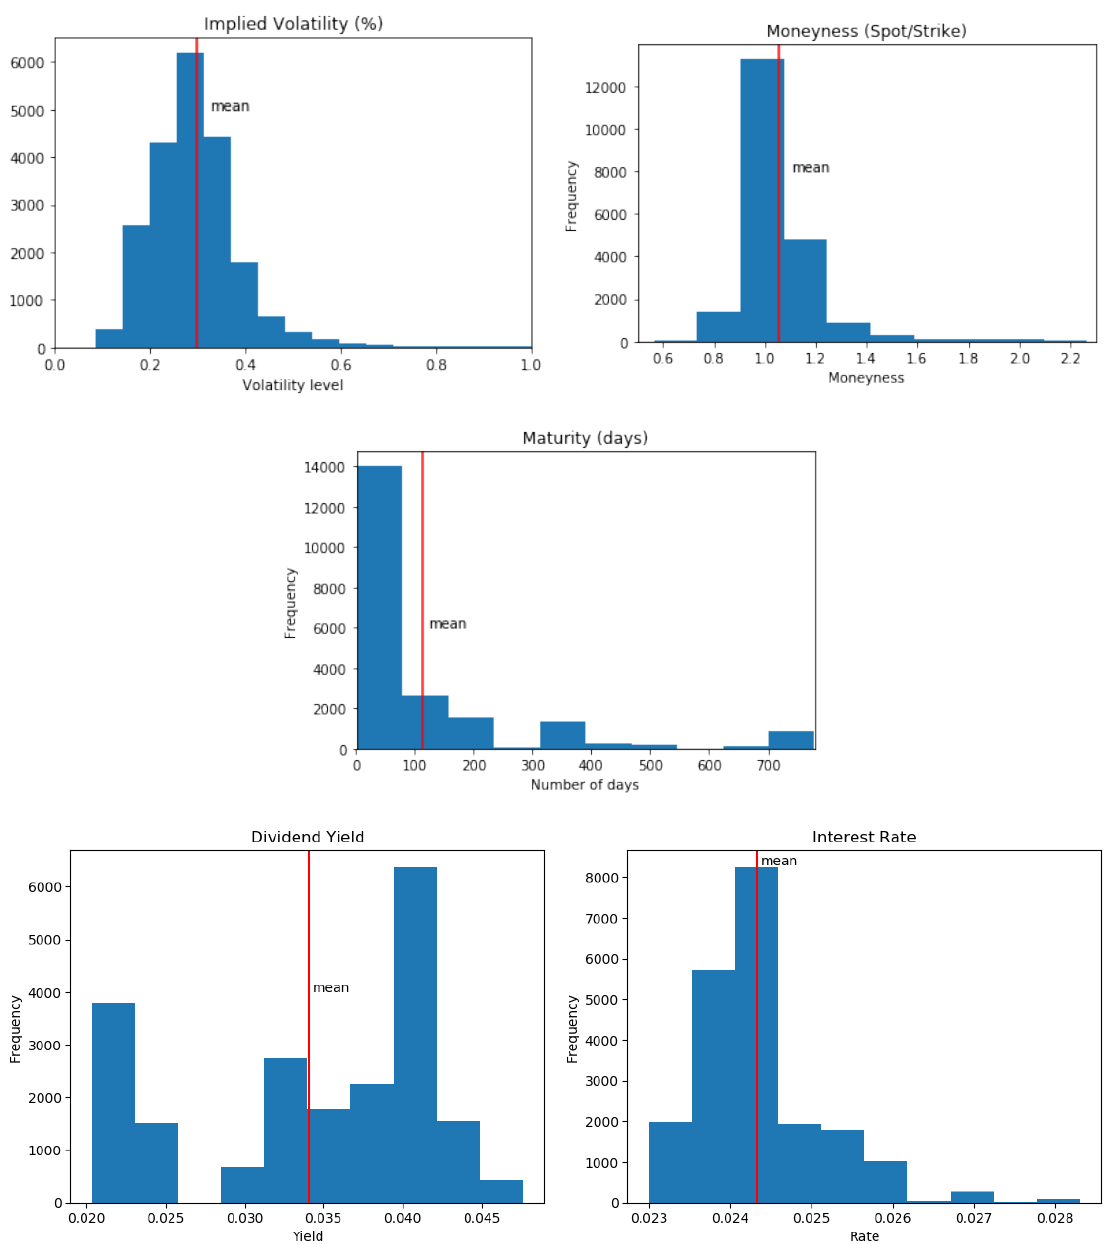
Figure 3. Input variables’